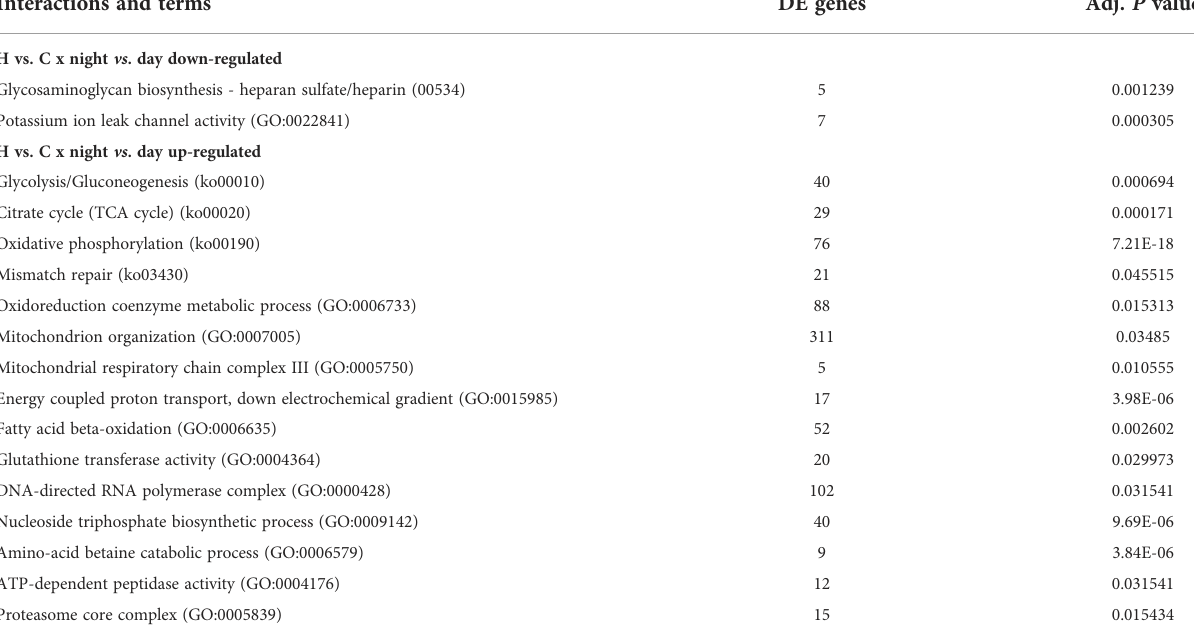
TABLE 1 Diurnal changes in transcriptional response to deoxygenation, in S. pistillata . Interactions and